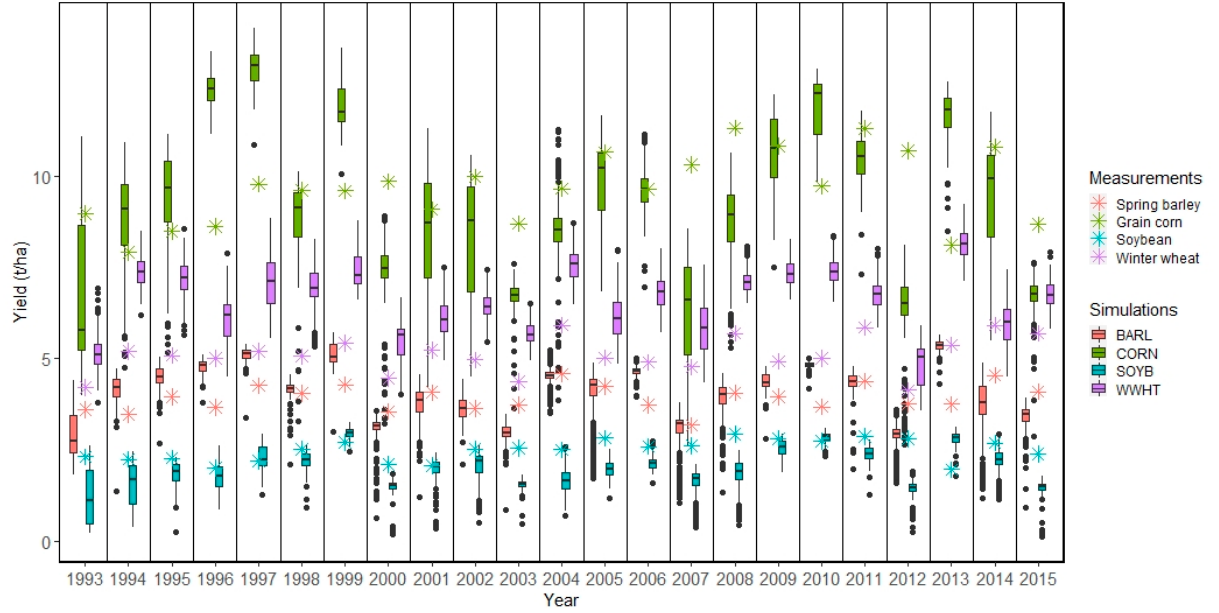
Figure 6. Measured and simulated crop yields at the HRU level in the Zaya catchment. The SWAT simulated crops BARL (spring barley), CORN (grain corn), SOYB (soybean), and WWHT (winter wheat) refer to Table S4.